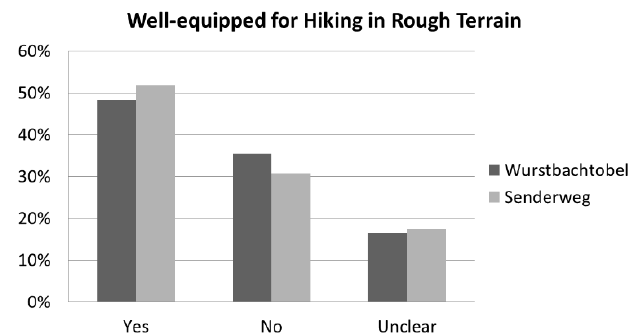
Figure 10. Percentages of individuals well-equipped for hiking in rough terrain in the Wurstbach- tobel and Senderweg monitoring sites, Grünten Mountain, Bavaria, Germany, based on periods with in-depth analysis of data (12,008